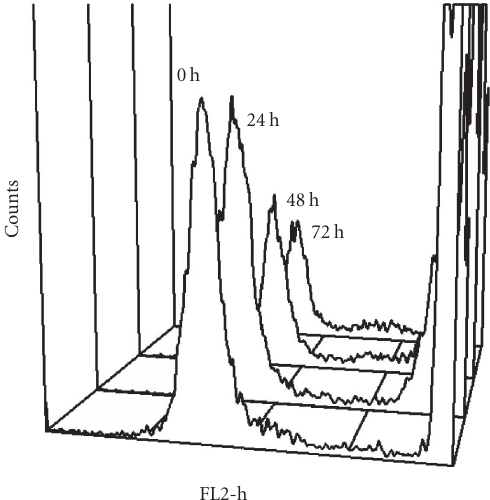
Figure 2: E ff ect of storage at 4 ◦ C on integrity of VEC based on propidium iodide (PI) staining. VEC were harvested and stored in KSFM for 24, 48, and 72 hours and were stained with propidium io- dide (0 . 5mg/mL in PBS). The x -axis shows the relative fluorescence of the particles analyzed. Shift of populations to the right reflects greater PI staining which indicates loss of cell integrity and increas- ing cell demise. The y -axis indicates the number of events (VEC) at each fluorescence level. PI staining yielded a biphasic pattern with the second peak (strong Fl-2 fluorescence) increased from 41 . 6% among fresh cells to 74 . 1% at cells stored for 72 hours supporting the use of freshly harvested VEC.